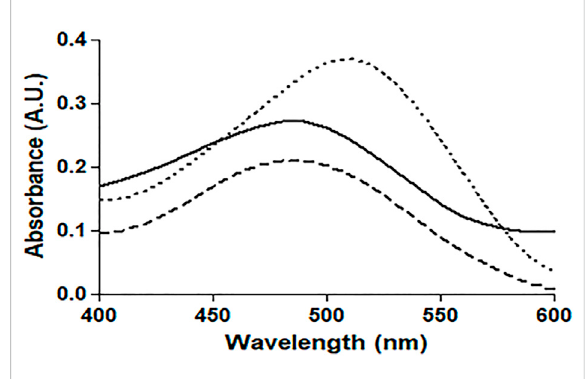
FIGURE 8 Absorbance pro fi le of native HSA ( ― ), 4-Cl-OPD modi fi ed HSA ( ۔۔۔ ),and Congo red alone( ⁃ ⁃ ⁃